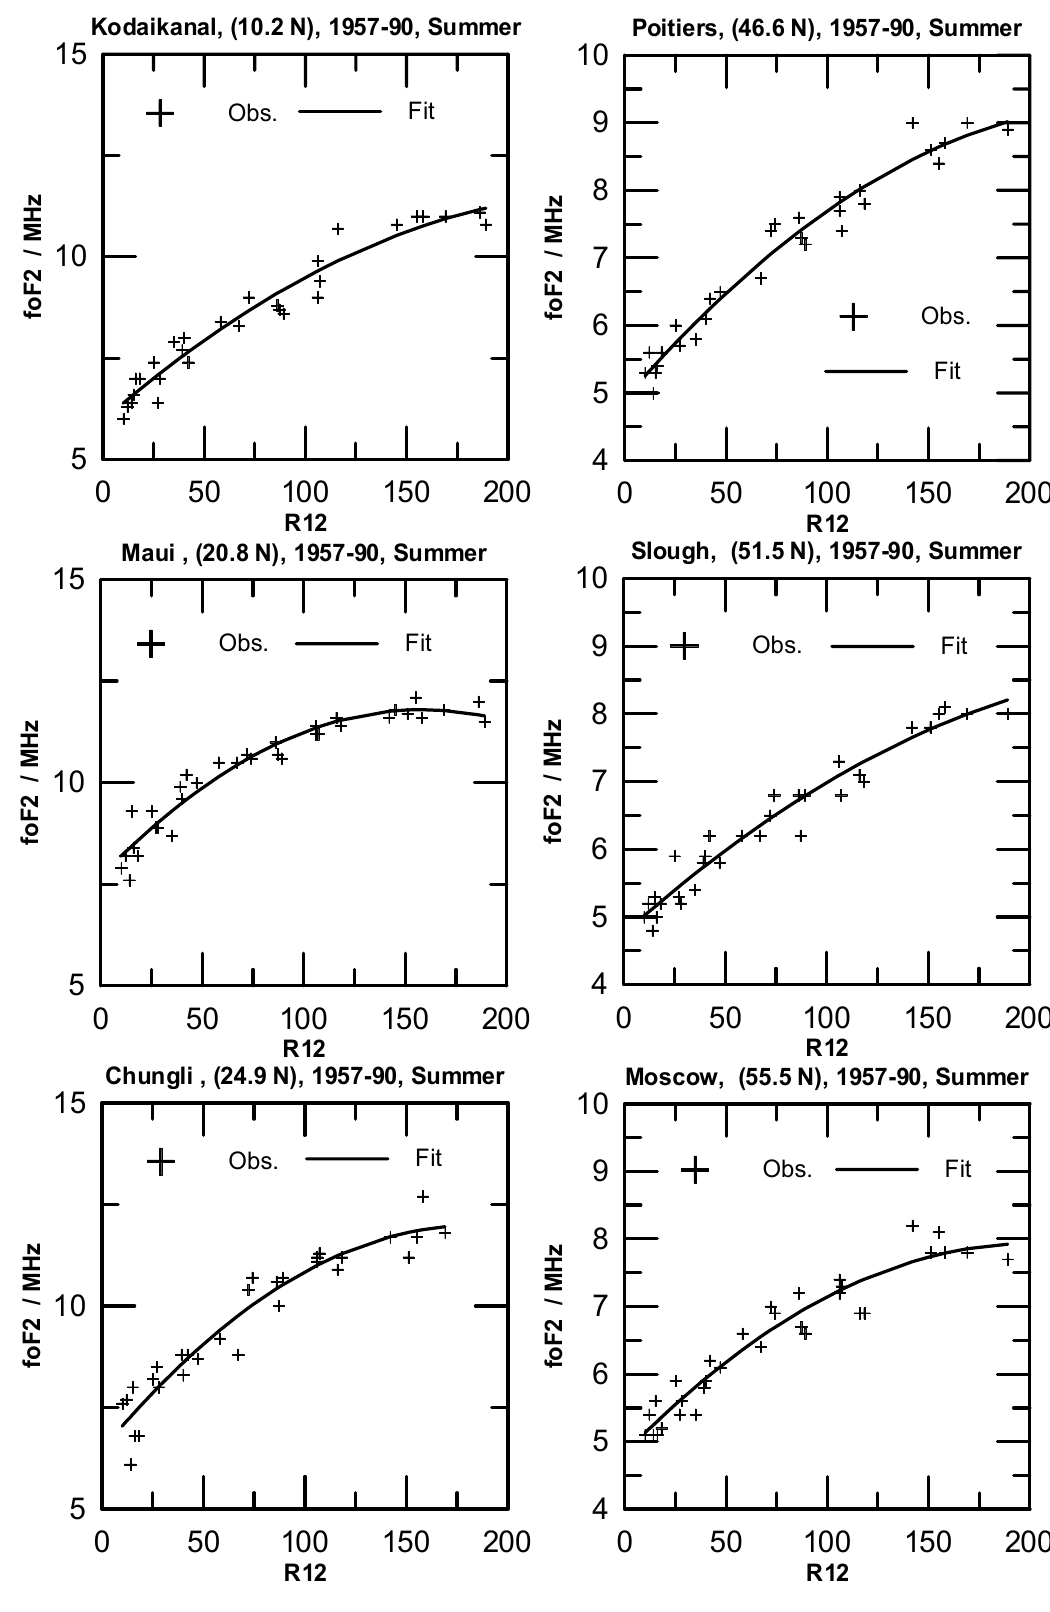
Fig. 1. Shows the plots of observed monthly median noon fo F2 values against R12 during summer. The regression fits are shown as solid line. The left panels show low latitude stations, while the mid-latitude stations are shown on the right panel of the